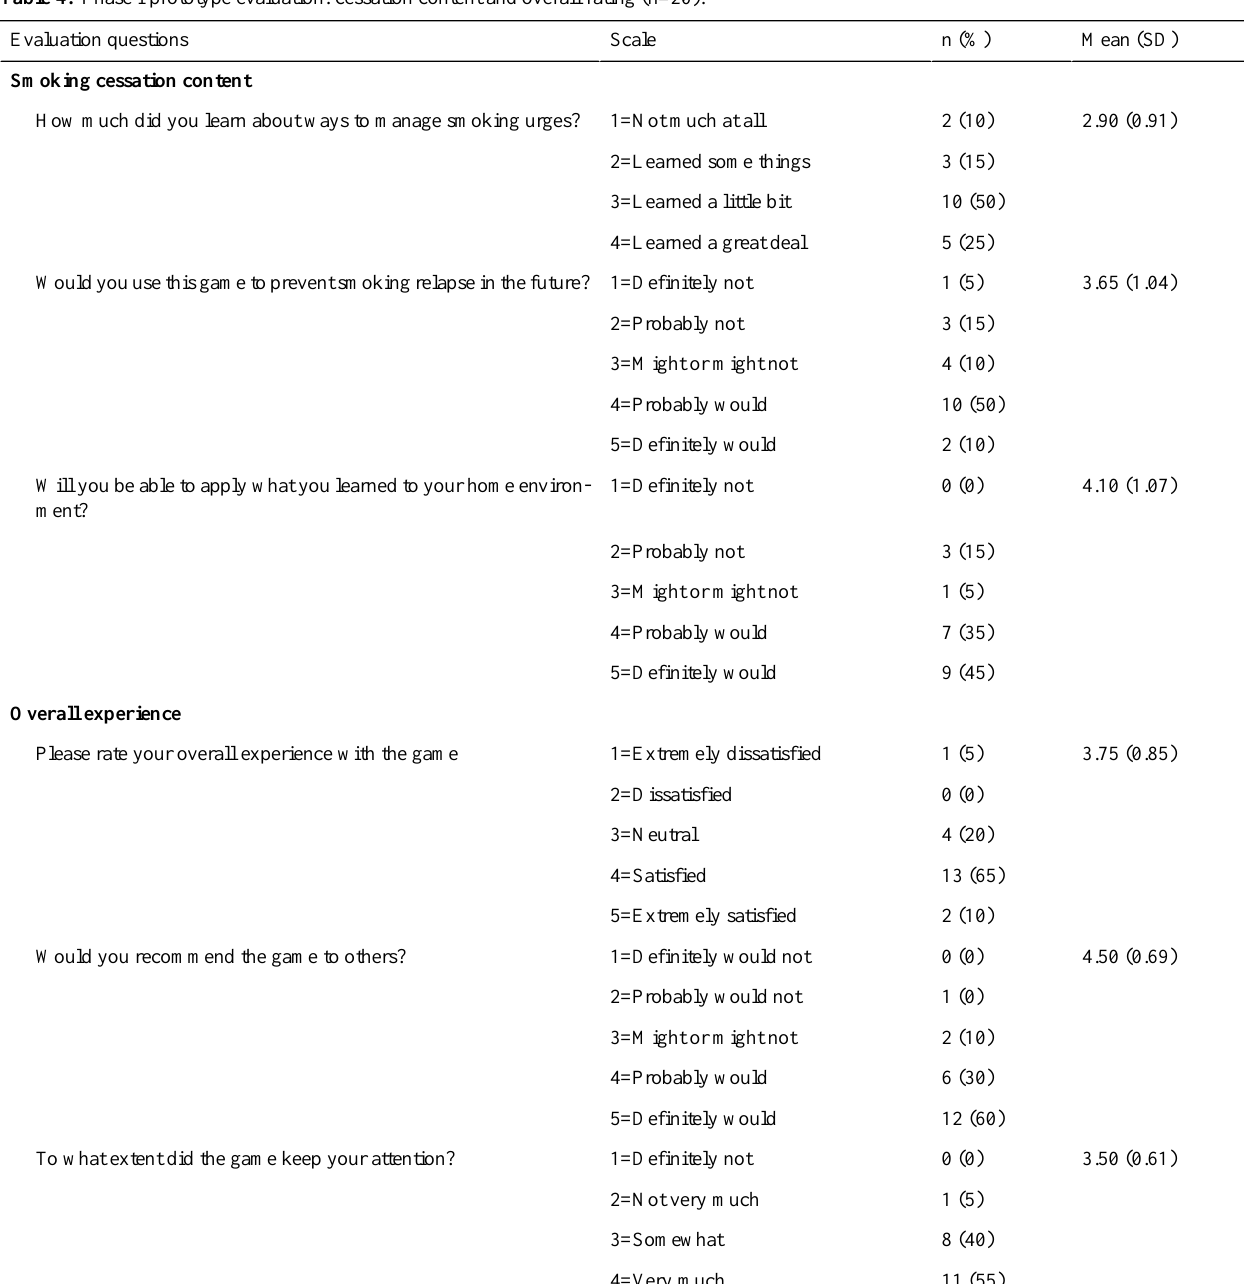
Table 4. Phase I prototype evaluation: cessation content and overall rating